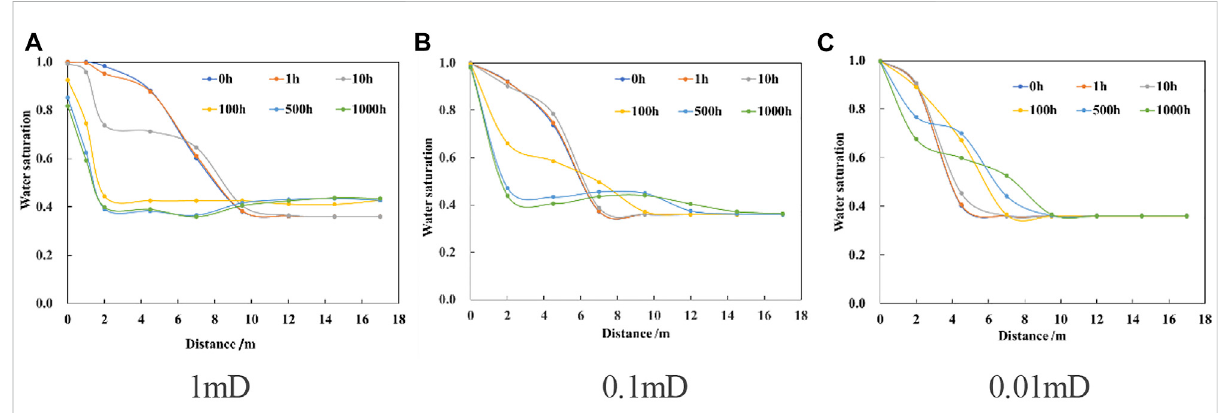
FIGURE 14 Watersaturationofthemainfractureatdifferenttransversedistancesindifferentpermeabilityzones.After10daysofdrilling,thepressureofthe splicing system is shown below. (A) 1 mD (B) 0.1 mD (C) 0.01 mD.